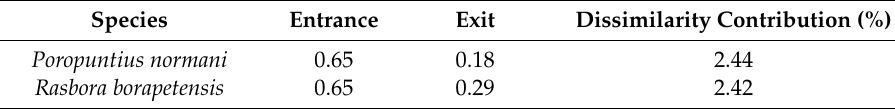
Figure 6. Length ranges of common species at the entrance and exit locations for the dusk / night experiment. Note, the solid black circles represent the mean values. Common species referred to the 10 most prevalent species (based on sample occurrence) recorded during both experiments. Table 2. Average prevalence (i.e., proportion of occurrence in samples) of species identified by SIMPER during the dusk / night experiment as important in contributing to between-treatment dissimilarity in community composition (based on presence-absence transformed community data). Each species contributed at least 2% of total dissimilarity and had a dissimilarity-to-standard deviation ratio of ≥ 1.